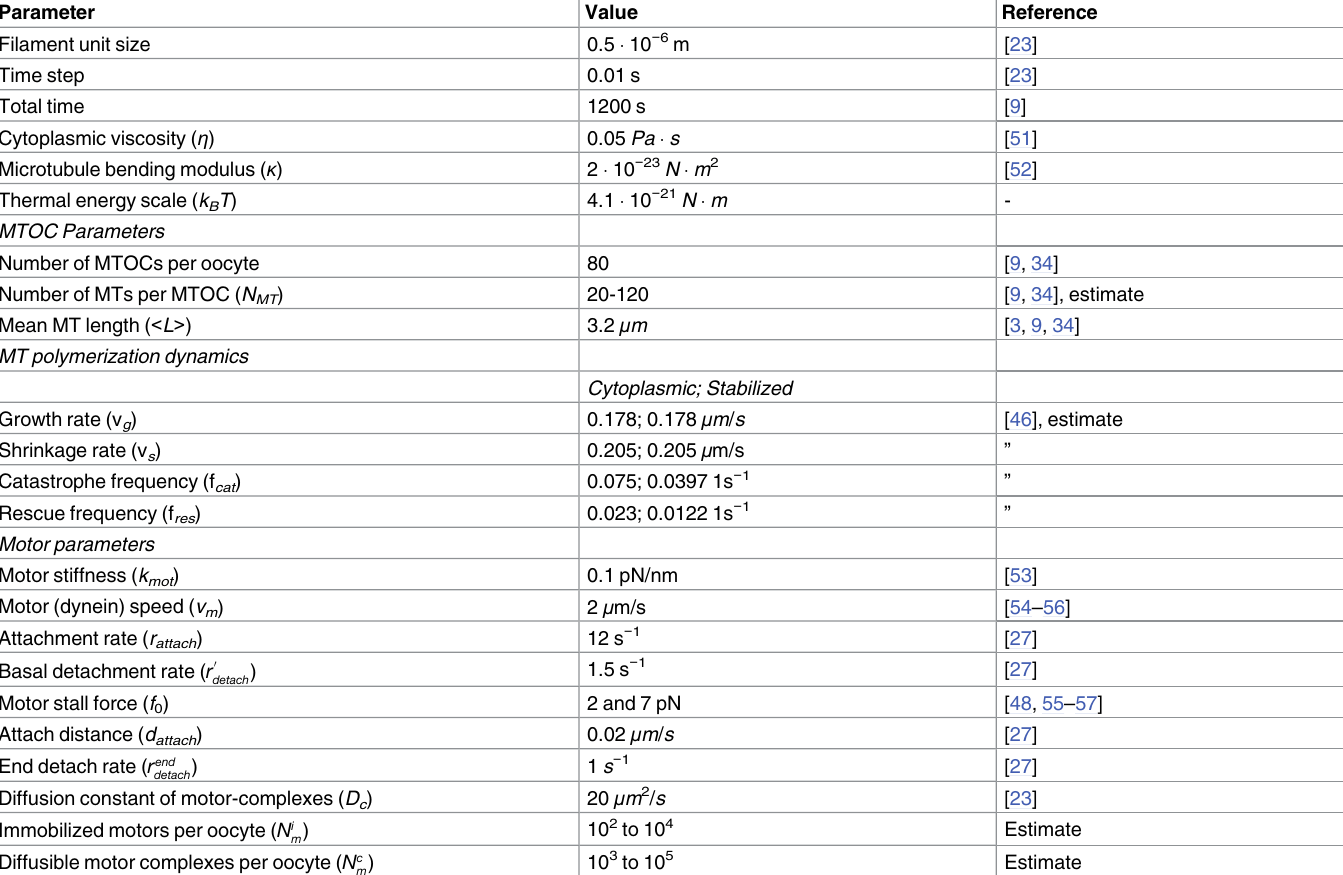
Table 2. MT-motor model parameters. The mecho-chemical parametersof motors were based on reported values for dynein, while motor densities were estimated. MT polymerization dynamics and mechanics is taken from literature, while cell geometry parametersare identicalto Table